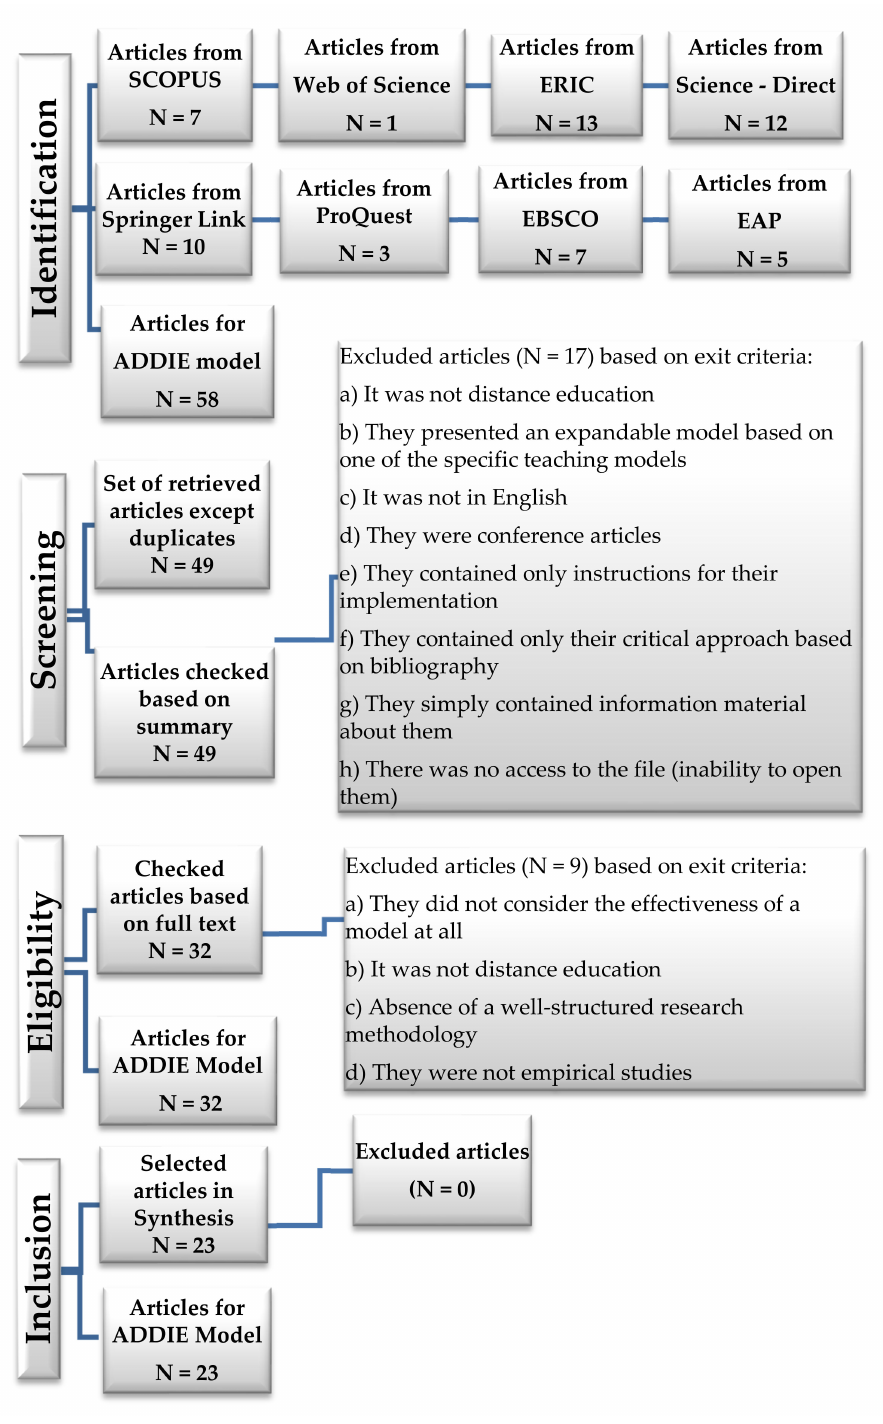
Figure 4. Flowchart for the article selection